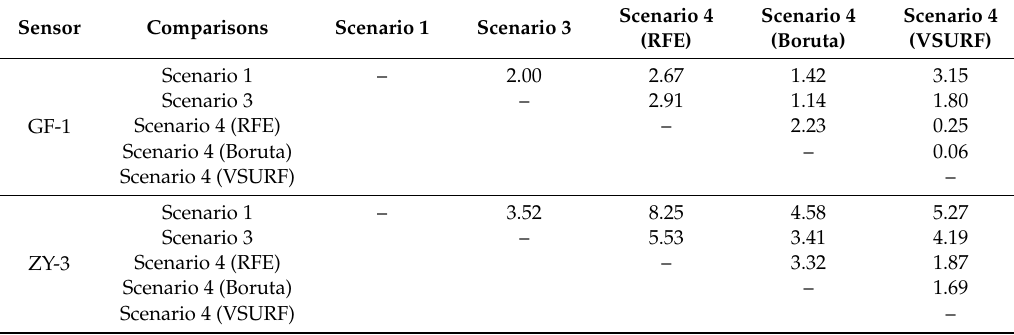
Table 12. McNemar’s statistic comparing the classification of each